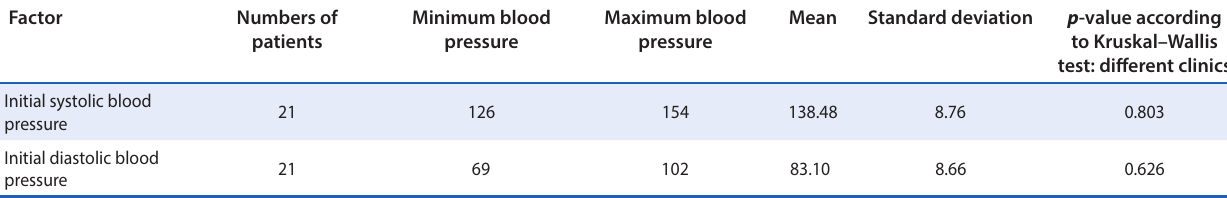
Table 3: Mean blood pressure of 21 patients at initial diagnosis Factor